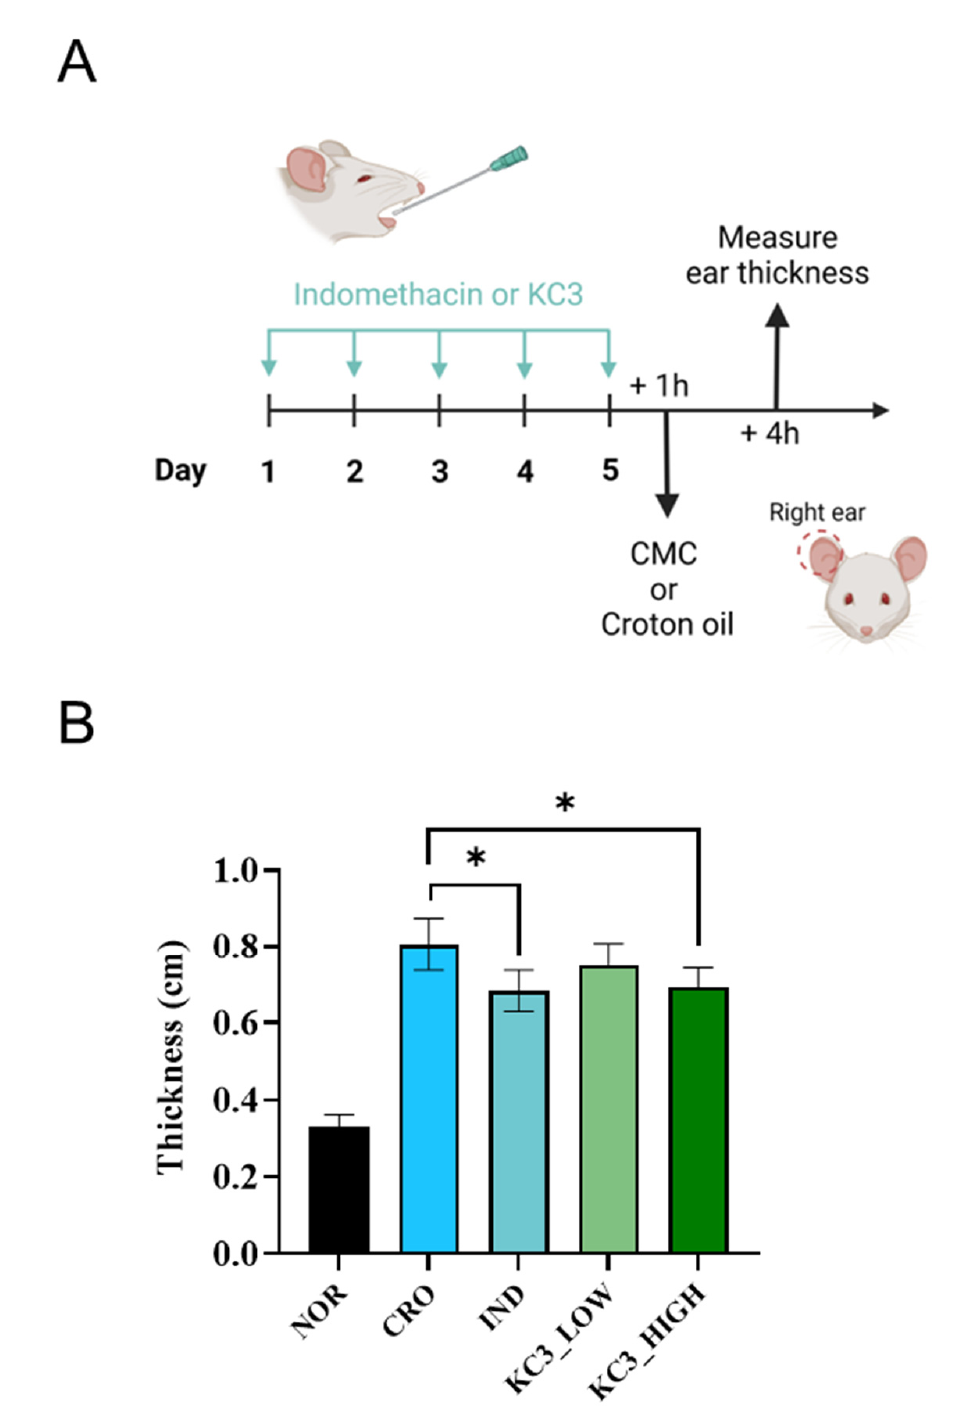
Figure 2. Ameliorating effect of KC3 on croton-oil-induced ear inflammation. ( A ) Schematic of anti-inflammatory evaluation using ear edema mouse model. Prophylactic treatment for five days was provided by oral gavage before applying croton oil. ( B ) Ear thickness was measured as an indicator of the severity of inflammation following croton oil application. IND, indomethacin. Data are represented as mean ± SD ( n = 5 per group). * Significant difference compared with the croton-oil-treated control group ( p < 0.05).